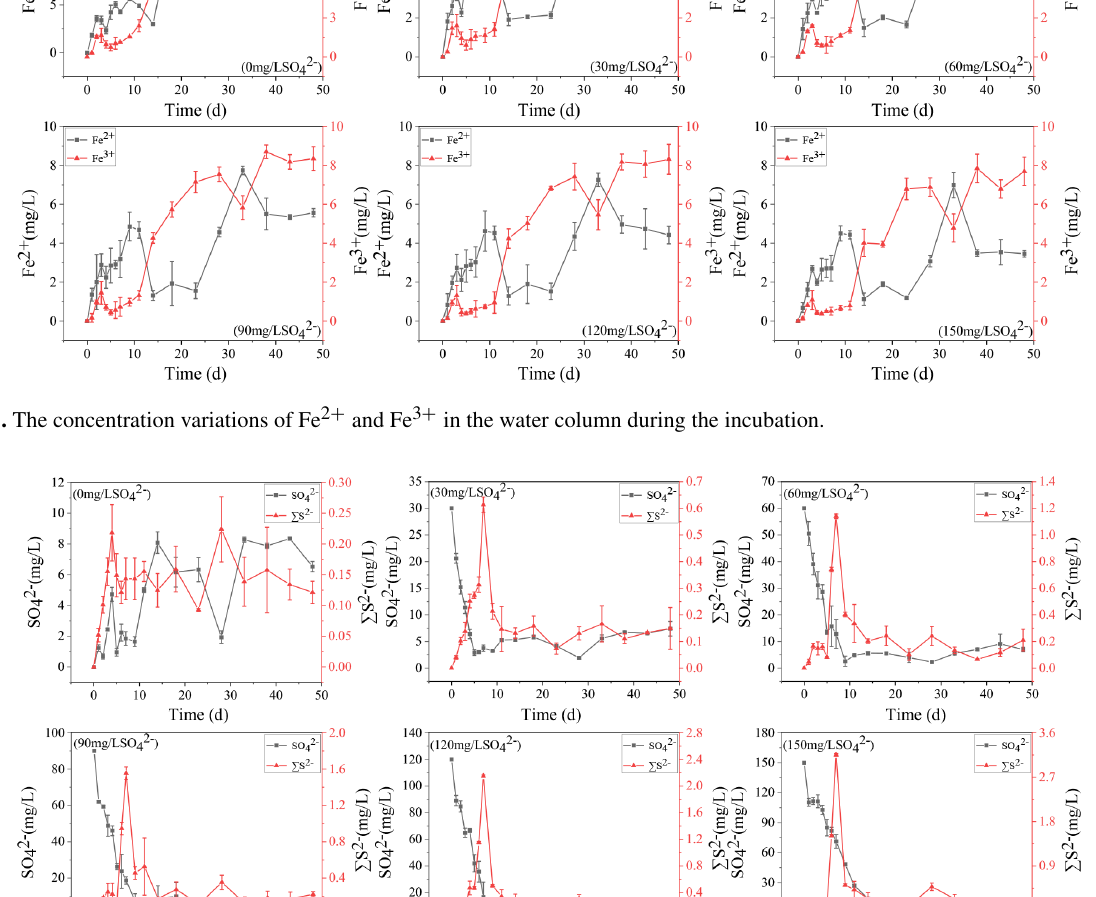
and (cid:80) S 2 − in the water column during the 4